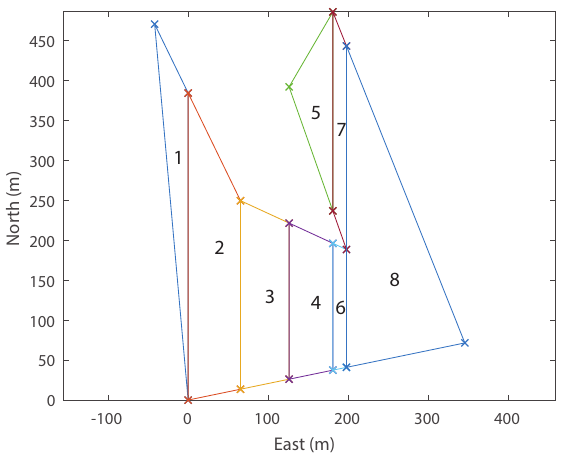
Figure 9. Example initial trapezoidal decomposition run on the example polygon from Figure 8a rotated by 90 ◦